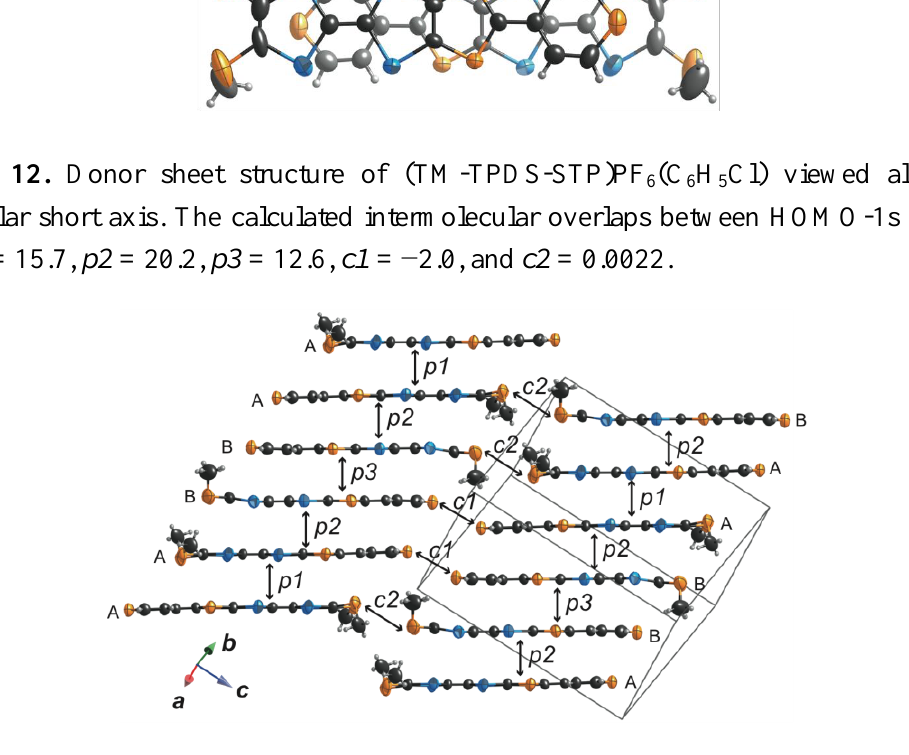
(C H Cl) viewed along the 6 6 5